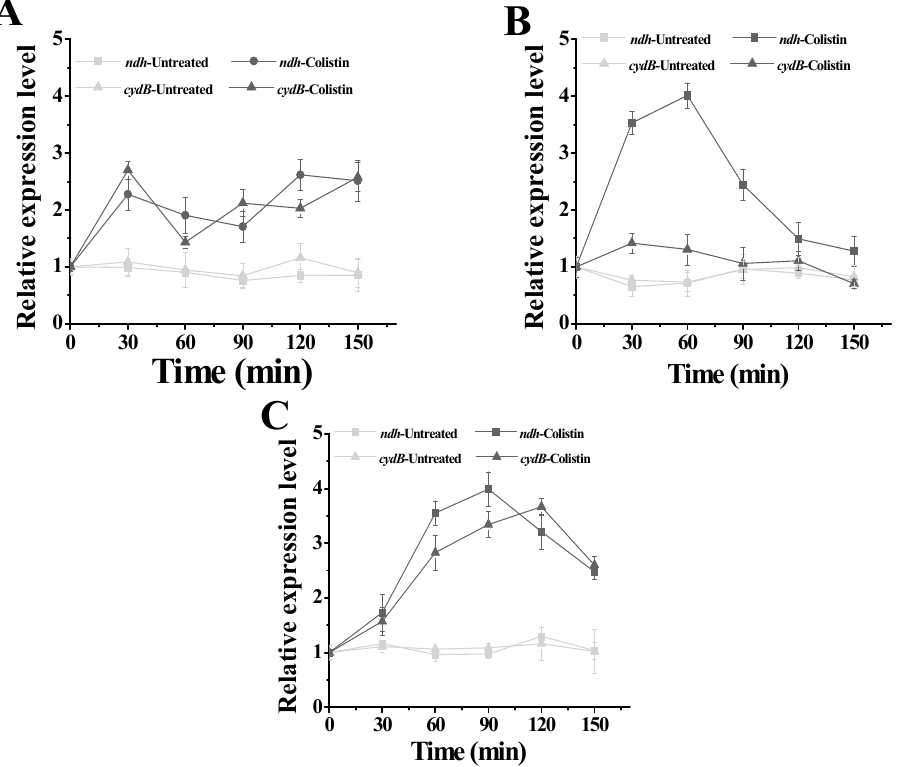
Figure 5. Effect of colistin on relative expression level of genes in respiratory chain. ( A ) Bacillus subtilis WB800; ( B ) Paenibacillus polymyxa C12; ( C ) Paenibacillus polymyxa ATCC842. ndh encoding NADH dehydrogenase; cydB encoding cytochrome d ubiquiton oxidase subunit 2.